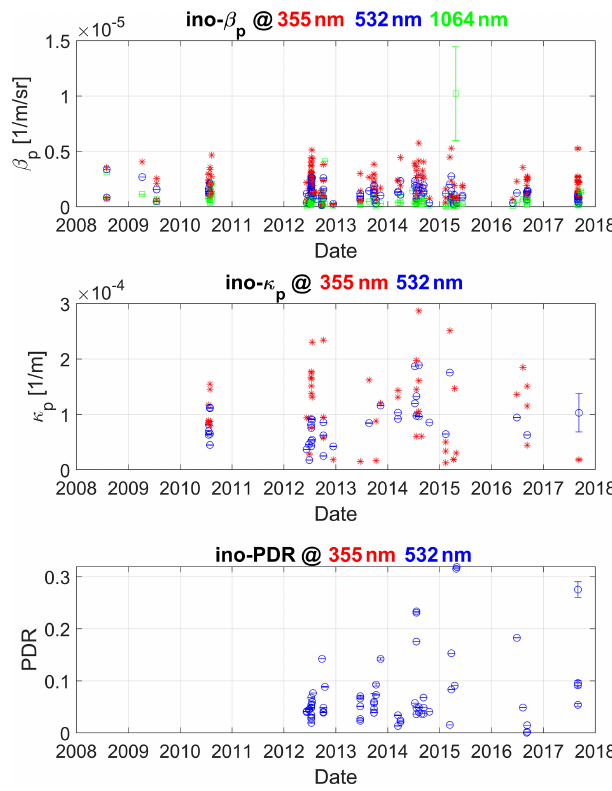
Figure 5. Values of the mean optical properties and associated un- certainties in the layers. Example for the Bucharest (“ino”) station. Layers were identified as having a fire source. Note that with few exceptions the uncertainties are very small and thus undiscernible from the mean